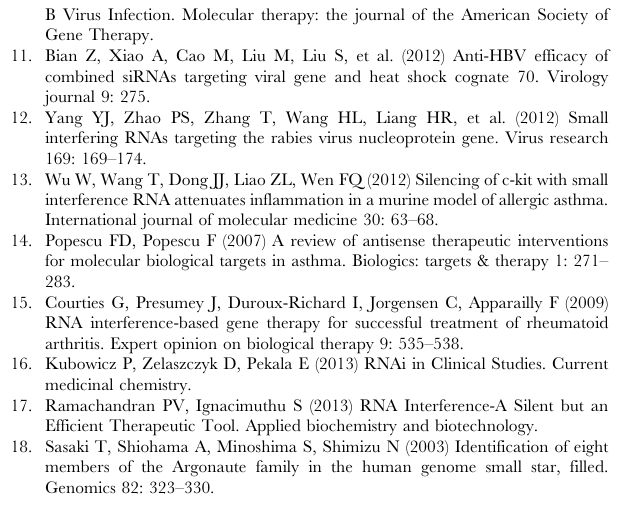
Figure S1 Structure and NMR of 5-methyl uridine monophos- phate. (DOC) Figure S2 Thermodynamic signatures of UMP, GMP, CMP, TMP and dGMP binding with Ago2PAZ domain. (DOC) Figure S3 the binding affinity of UMP, GMP, CMP, TMP and dGMP binding with Ago2PAZ domain. (DOC) Figure S4 Titration of Ago2PAZ domain with the rTMP. The top panel shows the raw calorimetric data referring to the amount of heat produced following each injection. The bottom panel shows the integrated amount of heat generated per injection as a function of the molar ratio of rTMP to protein. (DOC) Figure S5 Amino acid alignment from different Agos. The residues forming the cavity of nucleotides binding are included in green boxes. The residues of direct contact with nucleotides and enclosed by red boxes. Table S1 The output of analyzed RNAi (1 nM) data by STATA. A single-tailed one-way analysis of variance with Bonferroni’s multiple comparison test was conducted. Table S2 The output of analyzed RNAi (10 nM) data by STATA. A single-tailed one-way analysis of variance with Bonferroni’s multiple comparison test was conducted. Table S3 The calculated accessible surface area parameters of Ago2PAZ domain. VADAR program is used in the calculations with a solvent probe radius of 1.4 A˚